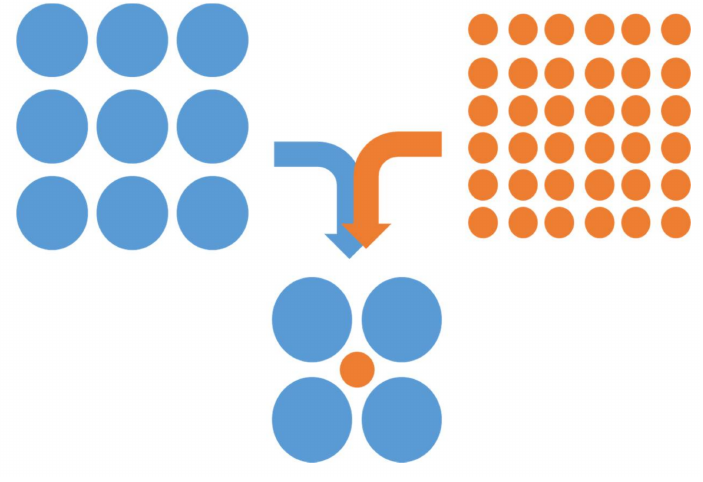
Figure 8. Schematic of the nano-porous effect formation for the binary monomer system with two monomers of different